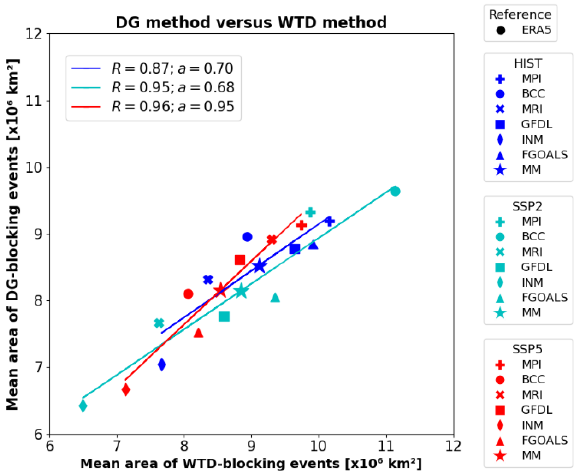
Figure 7. Mean area of blocking events computed with the DG method versus mean area of blocking events computed with the WTD method considering (cid:49) Z500 HIST , (cid:49) Z500 SSP2 , and (cid:49) Z500 SSP5 . R is the correlation; a is the slope of the linear re- gression; regression lines (found by the least-squares fit) are drawn when the correlation is statistically significant (at the 90% confi- dence